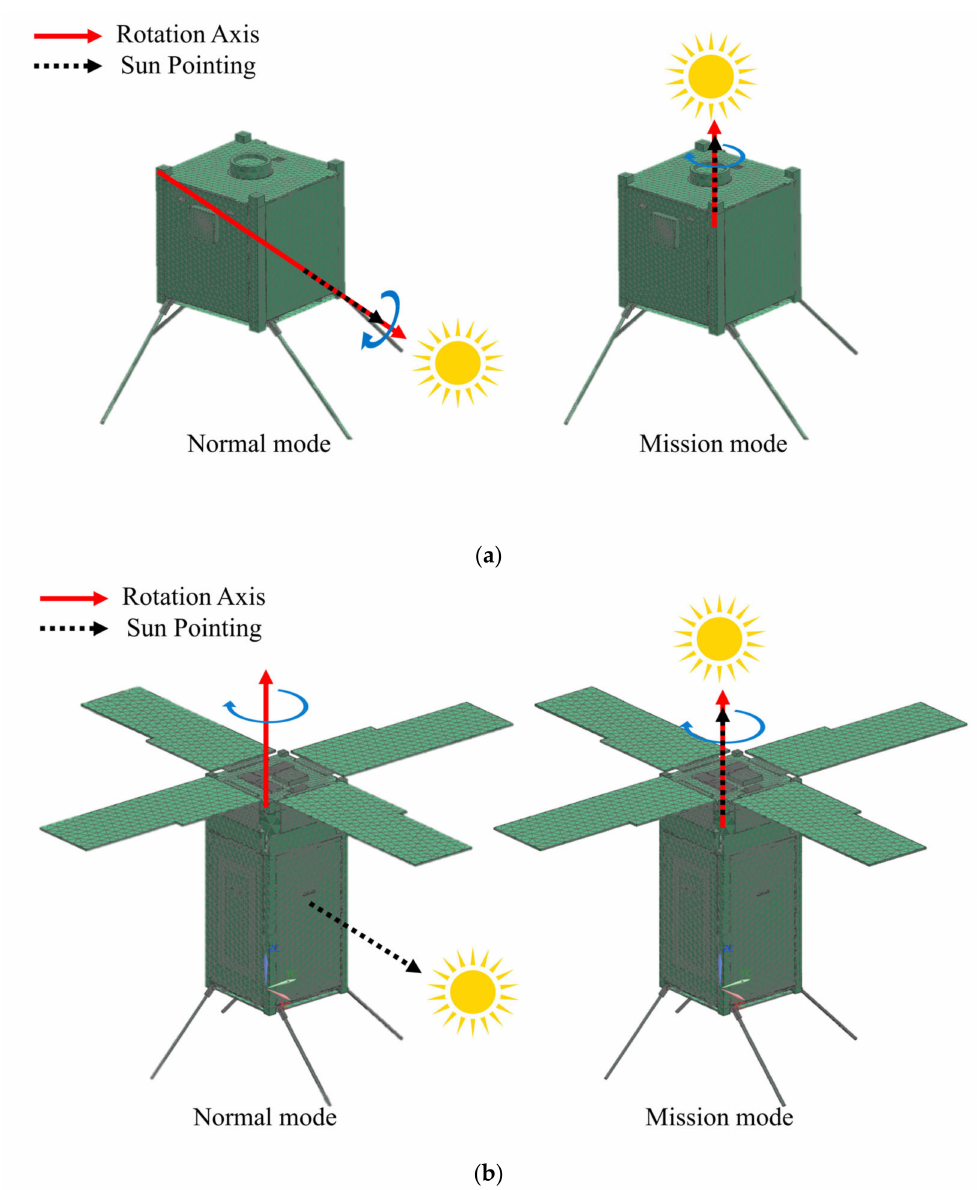
Figure 9. Attitude of CubeSats on the normal and mission mode: ( a ) Timon; ( b )